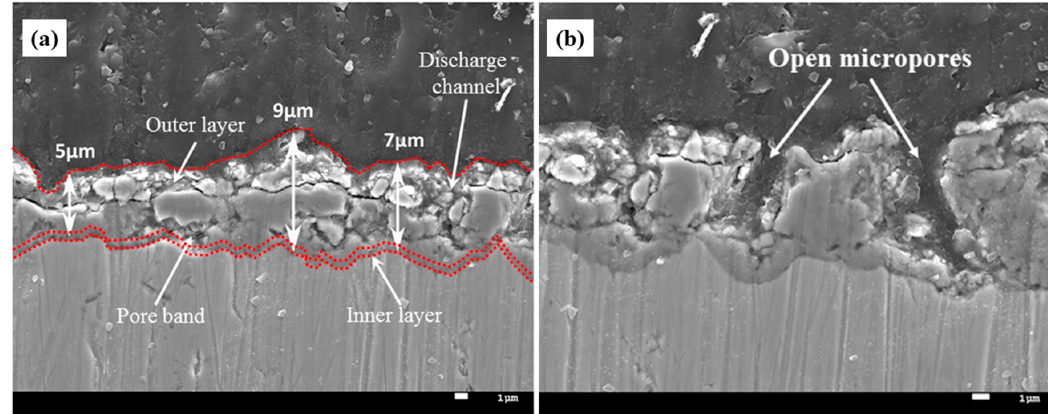
Figure 7. The cross-section morphology with: ( a ) two typical layers: inner layer and outer layer; ( b ) the open micro-discharge channels developed in the coating layer.